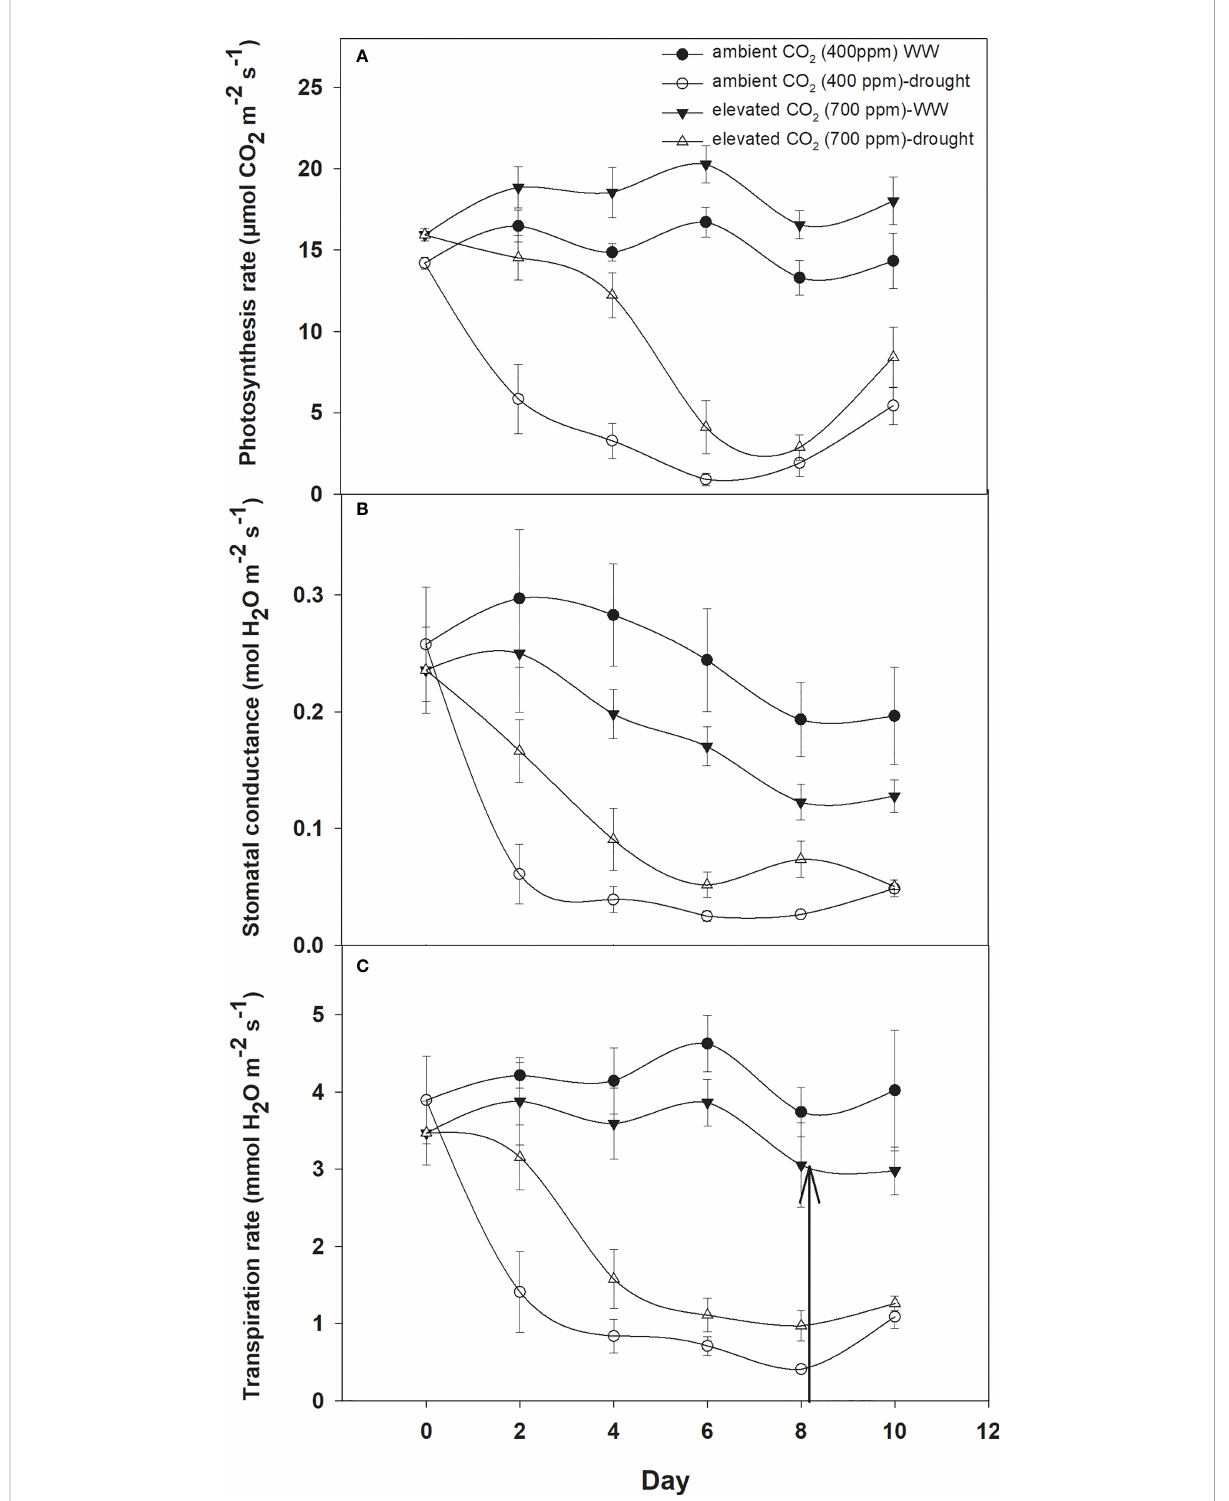
FIGURE 1 Effect of CO 2 concentrations and moisture conditions on (A) photosynthesis rate, (B) stomatal conductance, and (C) transpiration rate, of Datura stramonium . The vertical line on the data point represents the standard error of the mean and the vertical arrow line after Day 8 represents the addition of water in the drought treatments. WW,